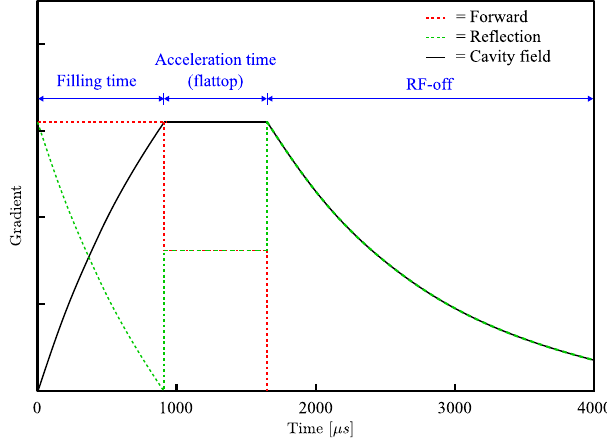
FIG. 1. Typical rf forward pulse, reflection, and cavity field signal in the case of no beam. The pulse signal is composed of filling time and beam acceleration